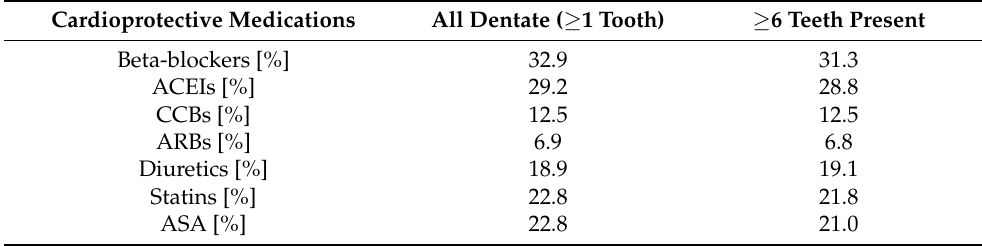
Table 2. Distribution of cardioprotective medications use across the dentate population. Cardioprotective Medications